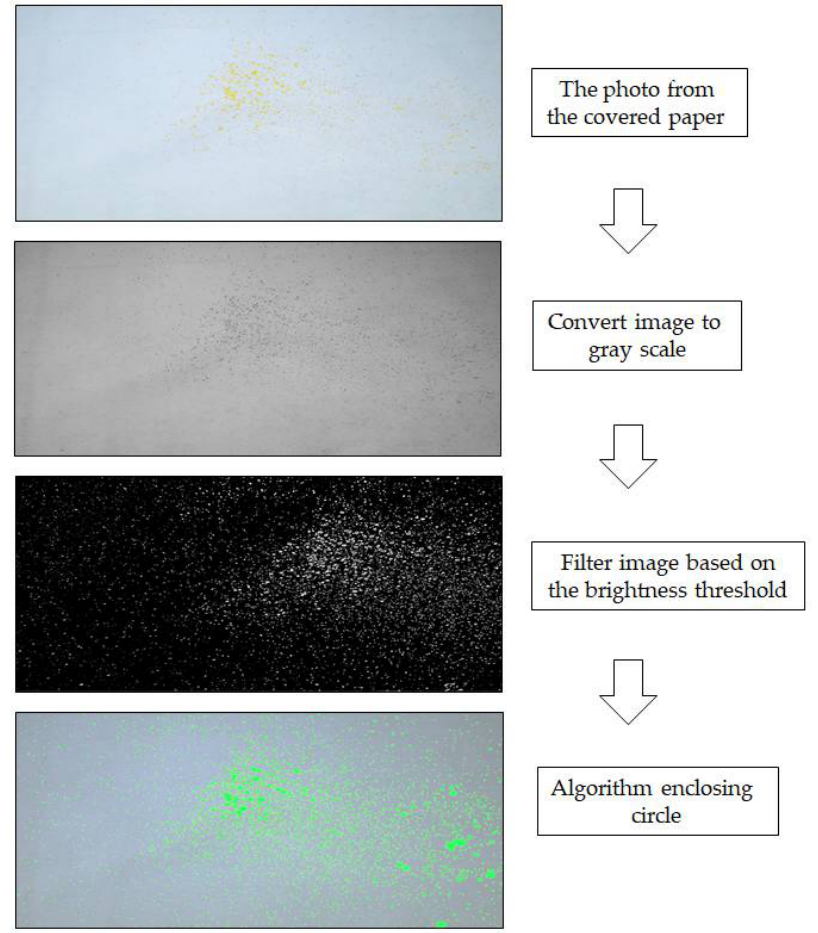
Figure 3. Image processing steps.